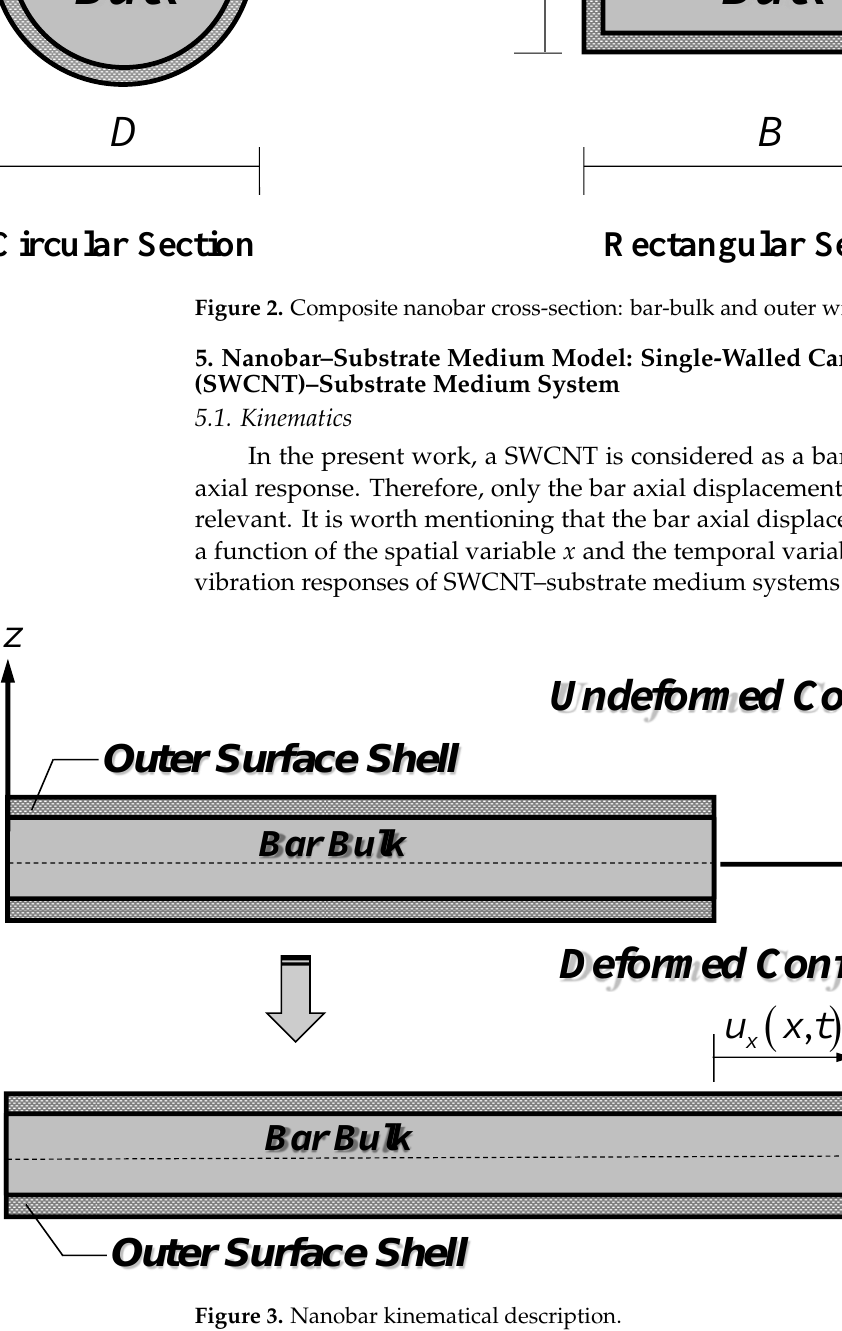
Figure 3. Nanobar kinematical description.